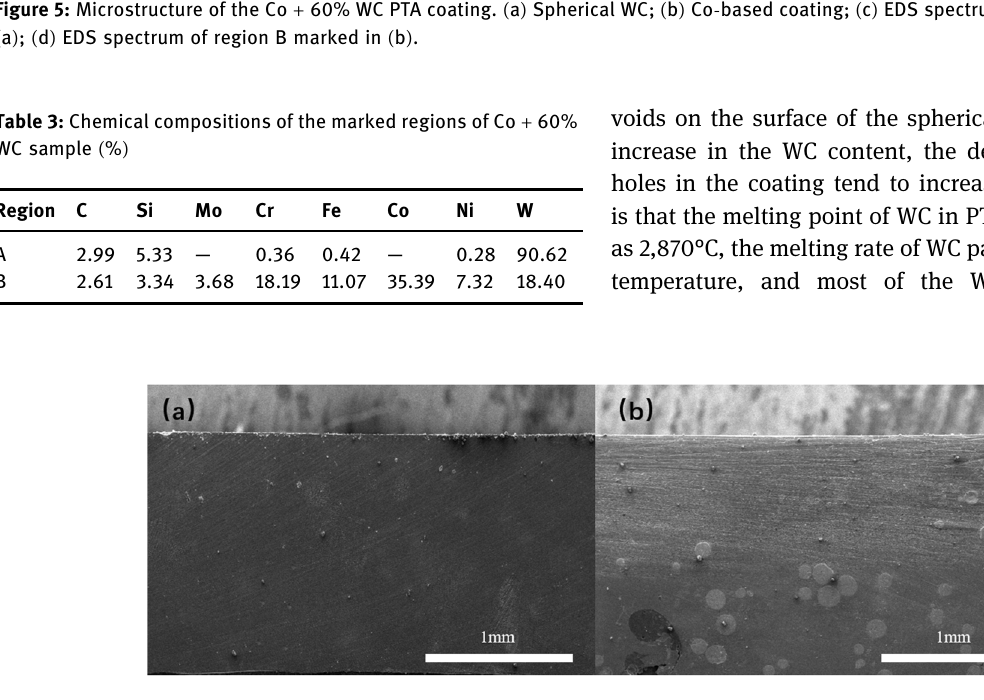
Figure 6: Microstructure of typical cross - sections of the composite coatings. ( a ) Co; ( b ) Co + 45%